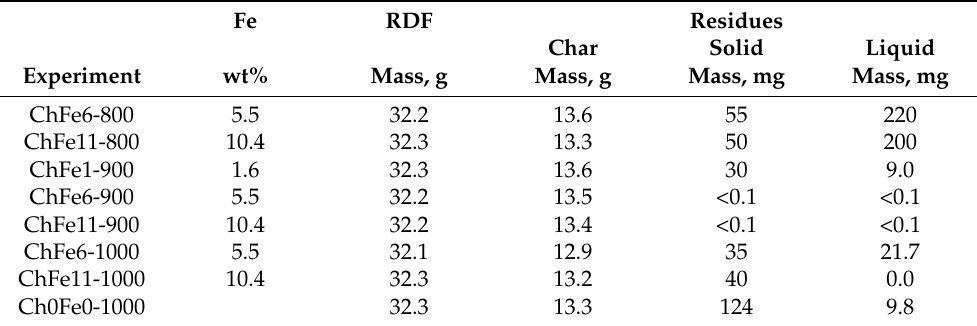
Table 4. Characteristics of experiment series: Fe concentration in catalysts and masses of RDF, char, solid, and liquid residues. Fe RDF Residues Char Solid Liquid Experiment wt% Mass, g Mass, g Mass,